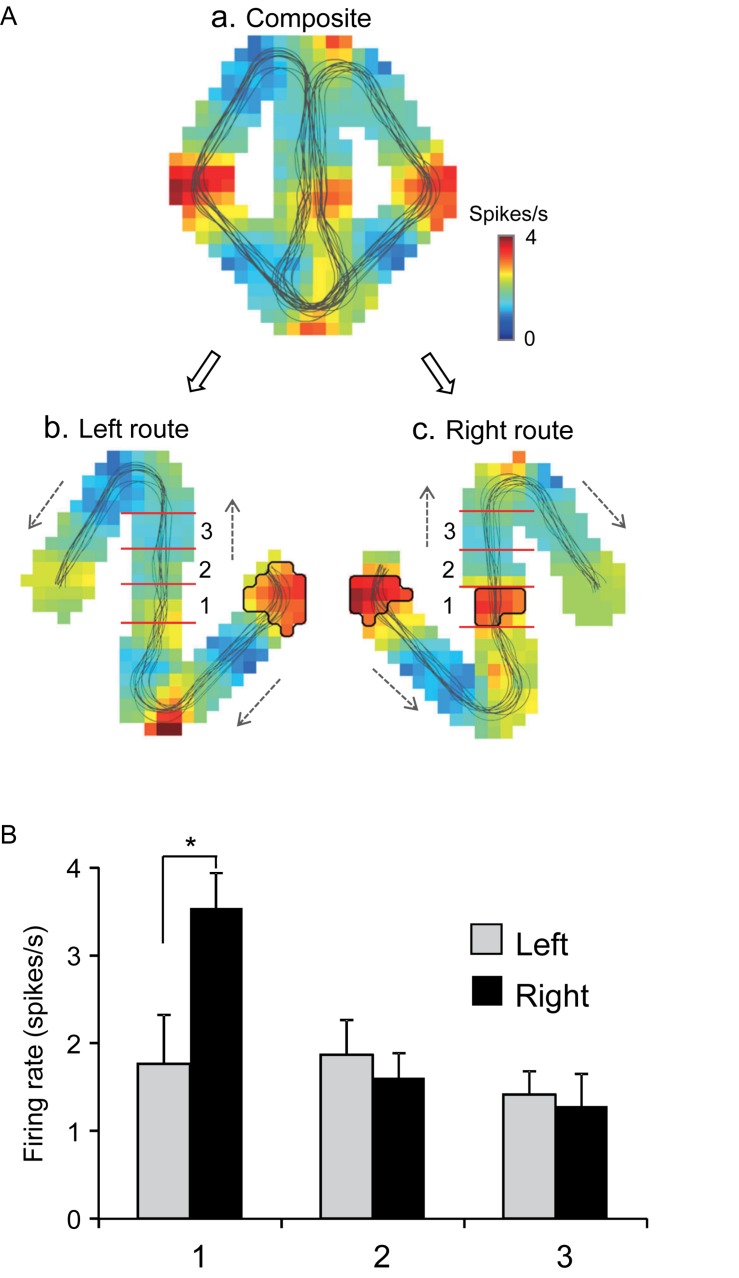
An example of a route-dependent place-related neuron in the VN task. (A) Firing rate maps. Place fields were identified near the R-reward area in the left route (b), and near the L- and C-reward areas in the right route (c). Trajectories of the monkey are indicated by thin lines on the firing rate maps. The place fields are marked using thick lines. (B) Comparison of mean firing rates in the three zones (1–3) in the left and right routes. ∗p < 0.05.